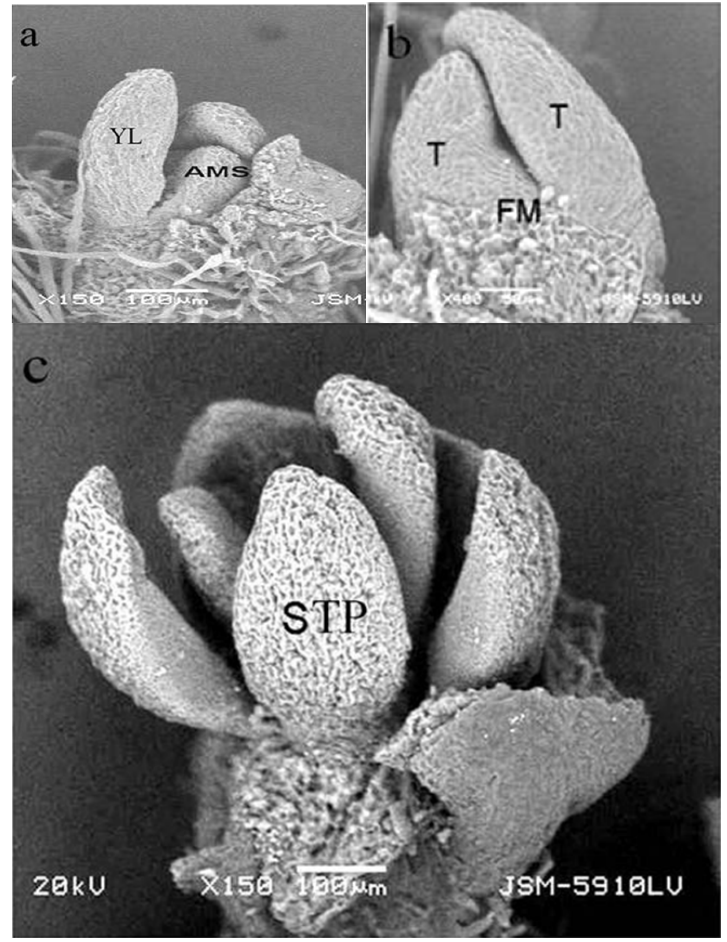
Fig. 2. Floral organogenesis in male flower viewed with scanning electron microscope. All bud scales have been removed in all. a. Apical meristem; b. First 2 tepals primordia; c. Stamens primordia; AMS-Apical meristem; YL-Young leaf; FM-Floral meristem; T-Tepal; STP-Stamen